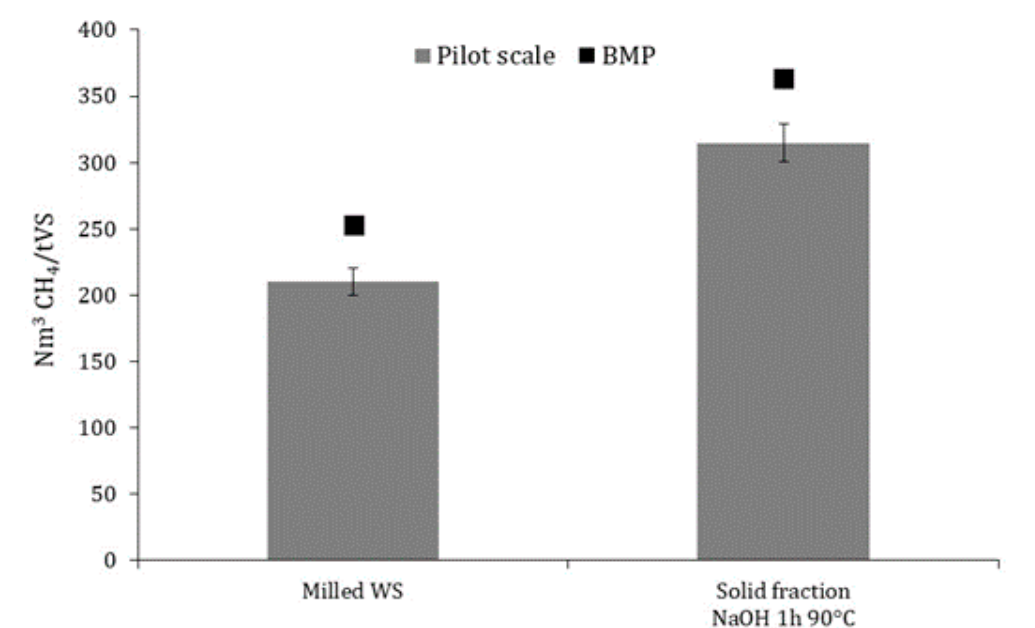
Figure 7. Comparison of methane potential (BMP vs. pilot-scale).